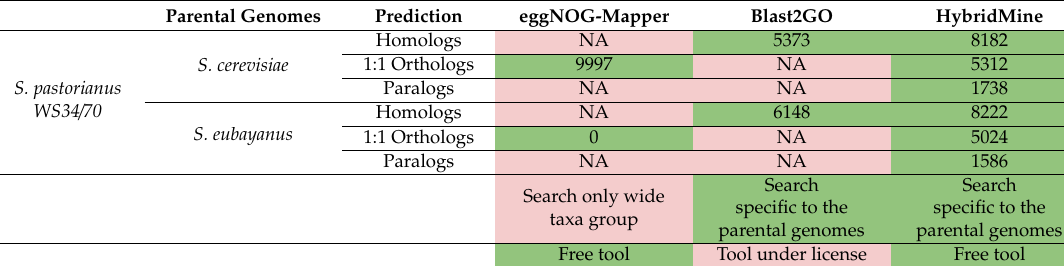
Table 1. Comparison between eggNOG-mapper, Blast2GO, and HybridMine. NA refers to a feature that is not provided within the tool. Green and red shaded areas highlight desirable and missing aspects of the